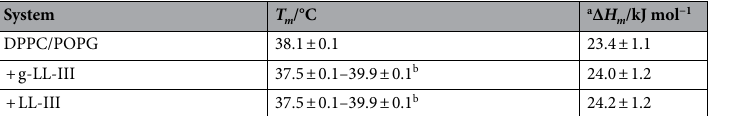
Table 1. Thermodynamic parameters for the gel-to-liquid phase transition of DPPC/POPG (8/2 mol/mol) MLVs, in the absence and presence of g-LL-III and LL-III at L/P = 10. a Normalization against total lipid moles. b The two indicated T m values refer to the first and second maxima in the